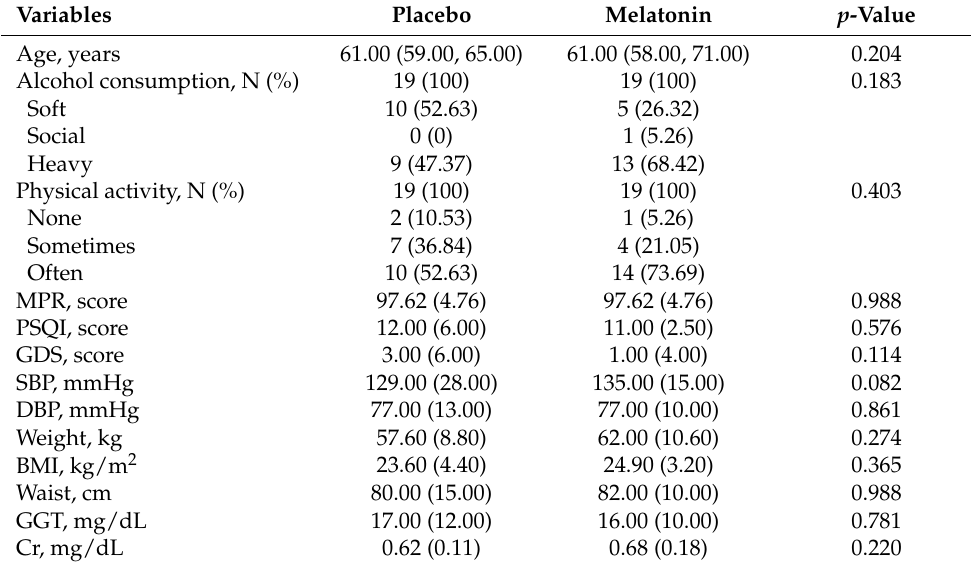
Table 1. Baseline characteristics according to